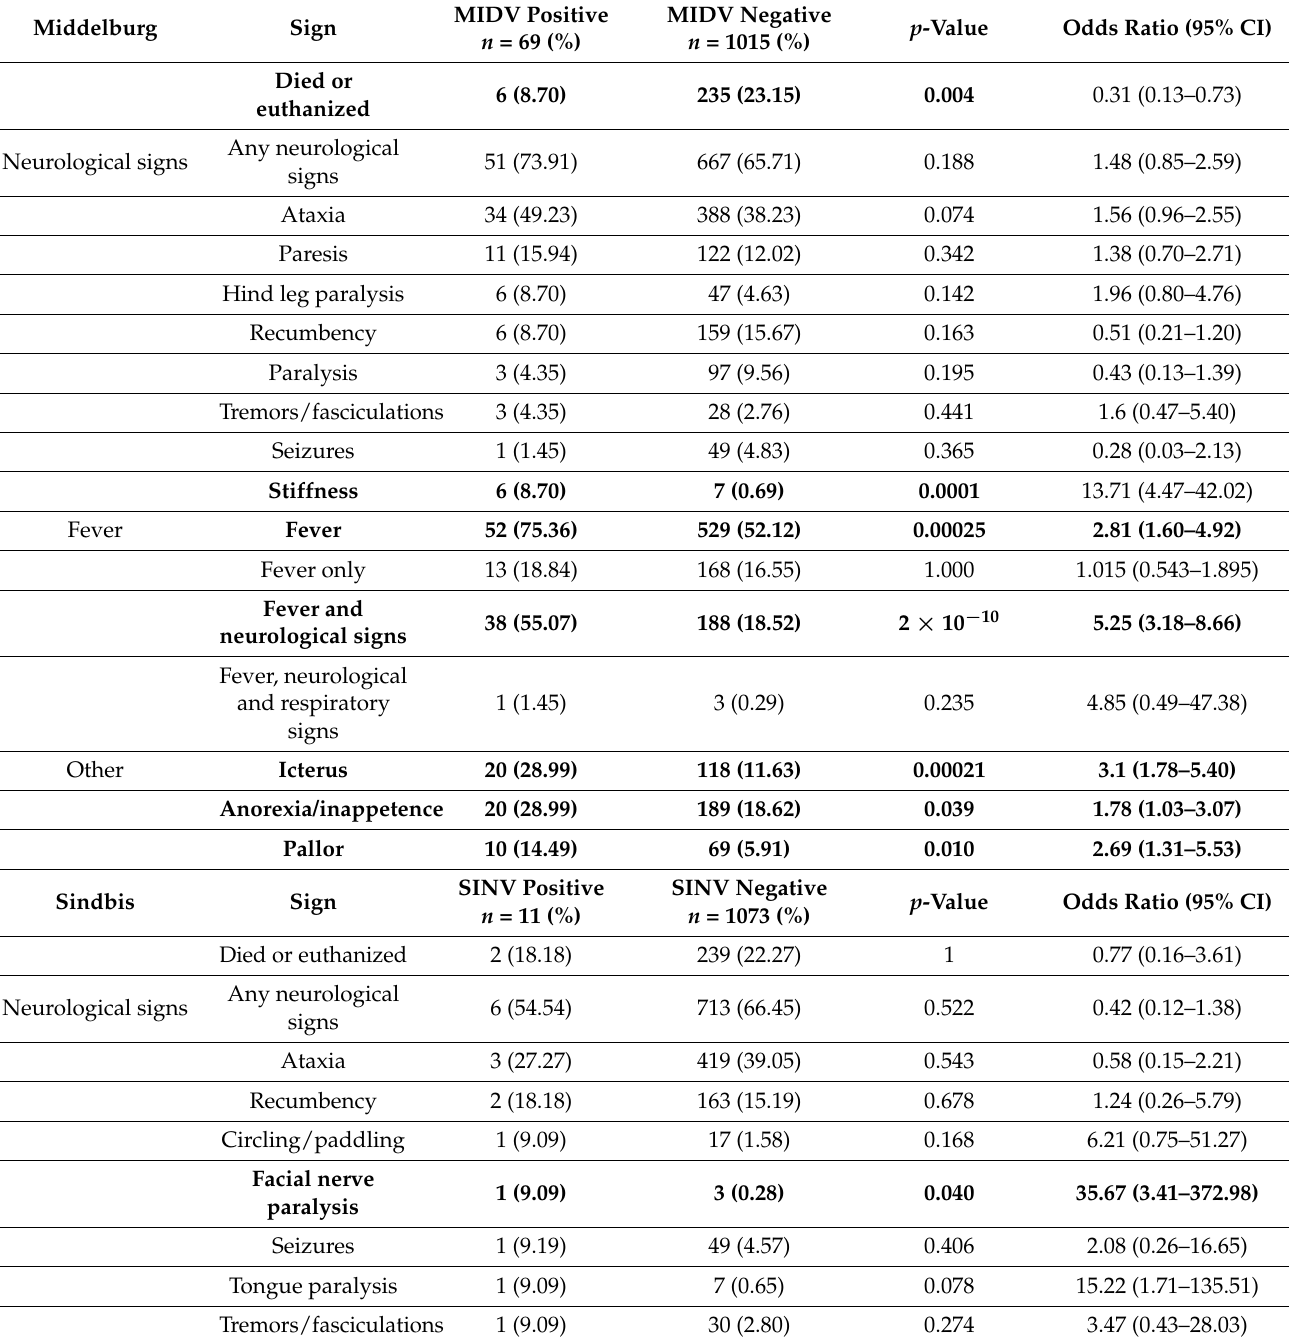
Table 3. Main clinical signs observed in MIDV and SINV positive horses from South Africa